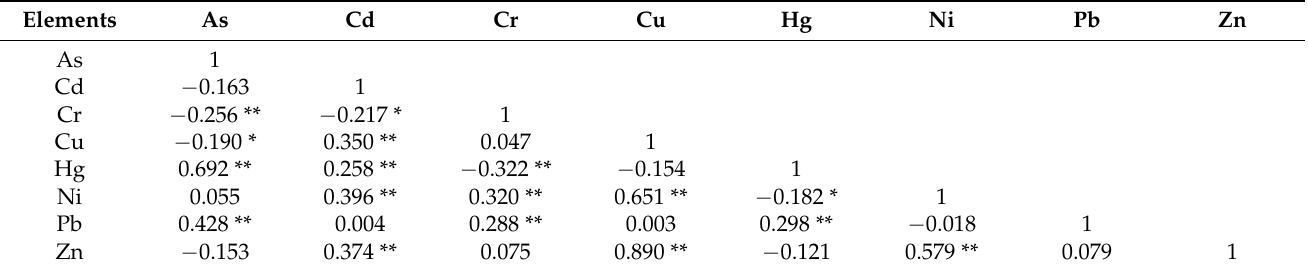
Table 6. Pearson correlation coefficients between heavy metals in stream sediments.